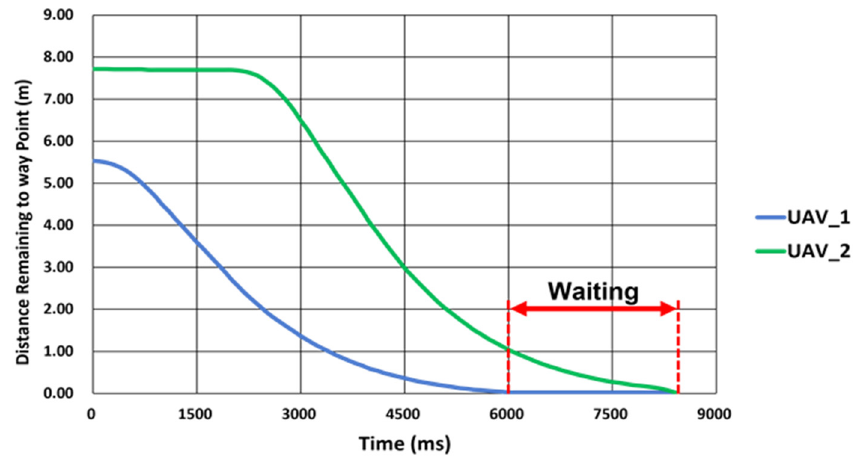
Figure 6. The altitude of each drone when waiting for different UAVs .